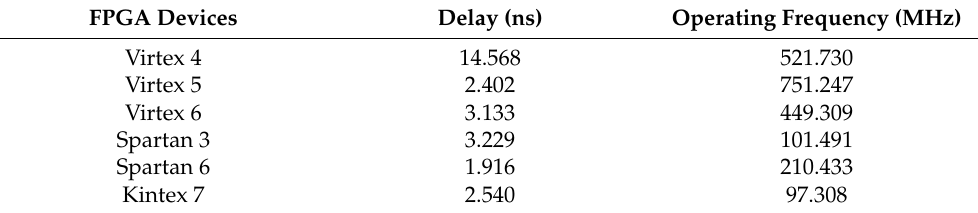
Table 6. Examination of delay and operating frequency for AES-